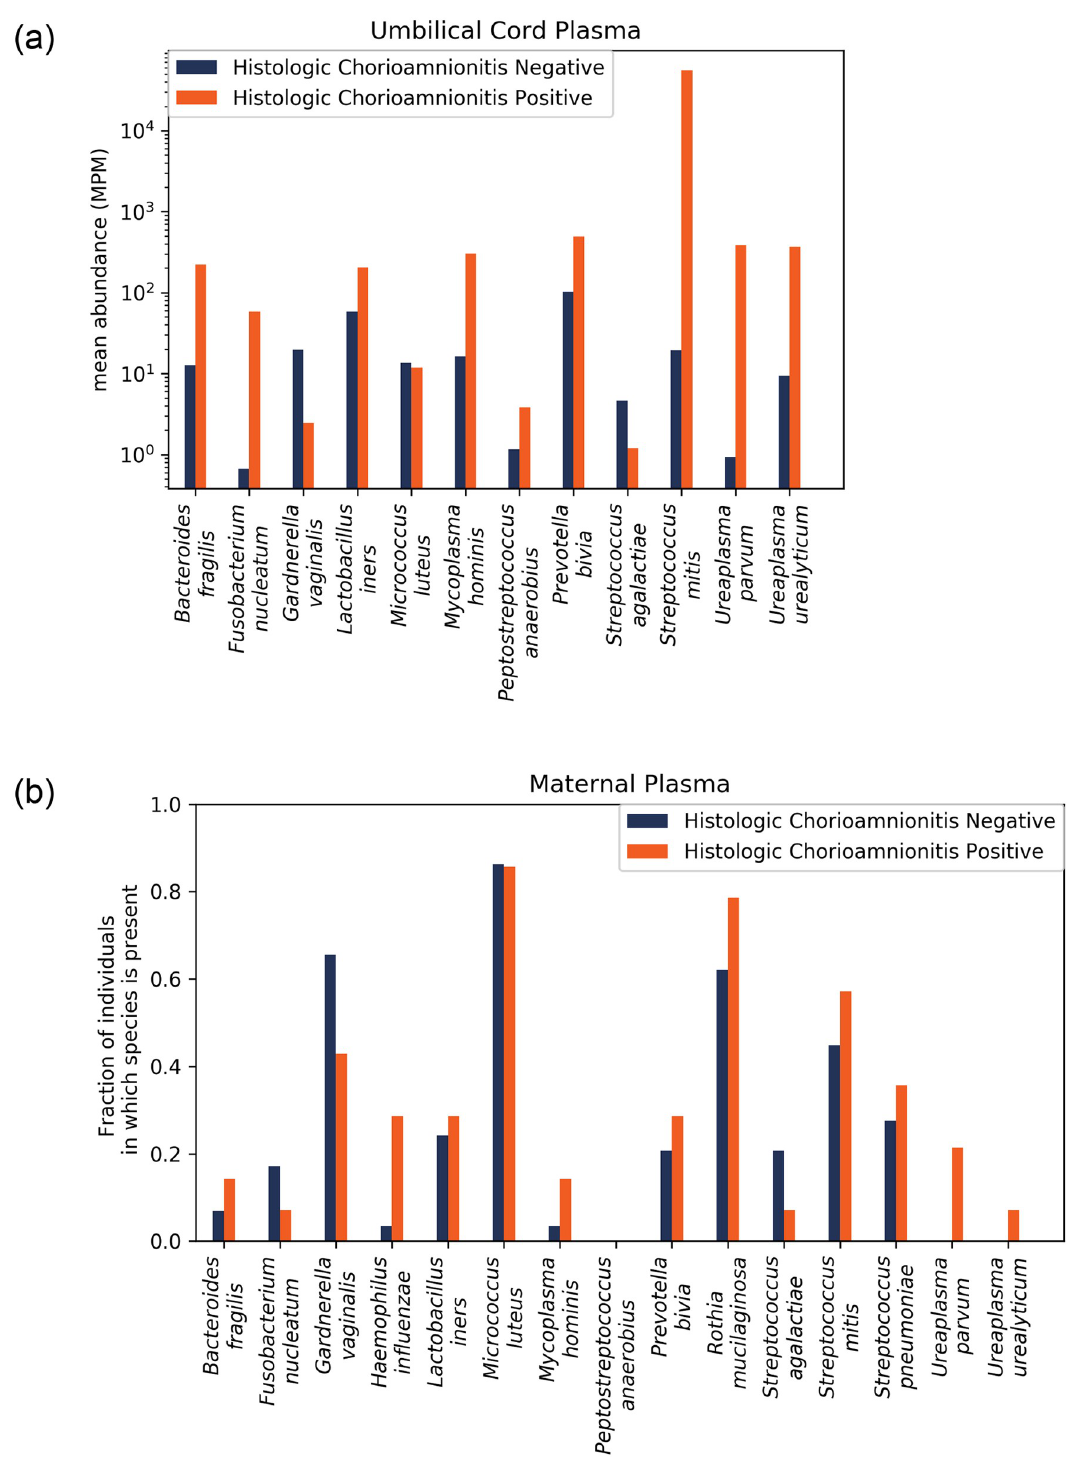
Fig 3. A. Microorganisms associated with chorioamnionitis are enriched in umbilical cord plasma of patients with histological chorioamnionitis. Comparison of the enrichment of microorganisms known to be involved in chorioamnionitis, intra-amniotic infections and preterm birth in cases with histological chorioamnionitis (n = 14) to cases where histology of the placenta was negative for chorioamnionitis (n = 29). B. Microorganisms associated with chorioamnionitis are enriched in maternal plasma of patients with histological chorioamnionitis. The enrichment of this set of microorganisms in maternal plasma is significant (p = 0.02).